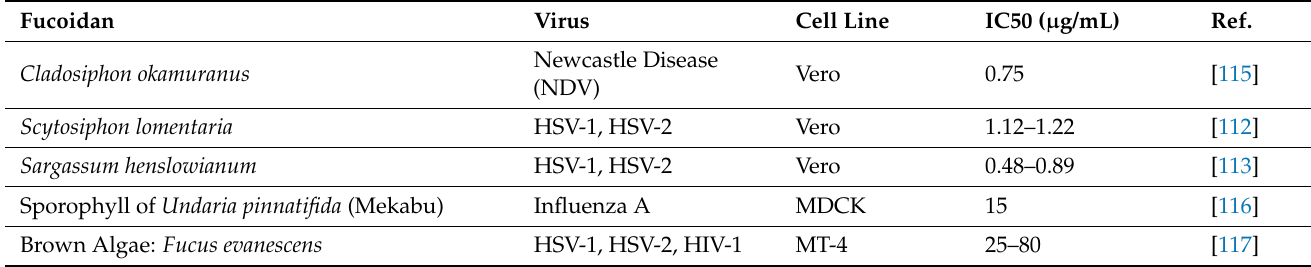
Table 4. Antiviral activity of fucoidans from different species of